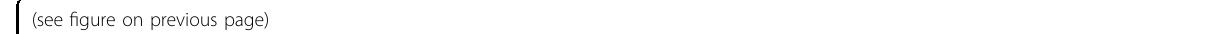
Fig. 2 USP39 promotes proliferation/invasion and epithelial-mesenchymal transition (EMT) of ovarian cancer cells. A – C Effect of USP39 on the proliferation of ovarian cancer cells was examined by ( A ) clonogenic, ( B ) growth curve and ( C ) EdU assays of ovarian cancer cells with USP39 overexpression (USP39) or knock down (sh-1 and sh-2) compared to corresponding control ( n = 5 for clonogenic assay and n = 3 for growth curve and EdU assays). The results of these assays indicated that overexpression of USP39 promoted, whereas knockdown of USP39 prevented, the proliferation of ovarian cancer cells. D Matrigel invasion data showing that overexpression of USP39 signi fi cantly enhanced invasion capacity, whereas knockdown of USP39 (sh-1 and sh-2) decreased the invasion potential of ovarian cancer cells ( n = 3 biologically independent samples).